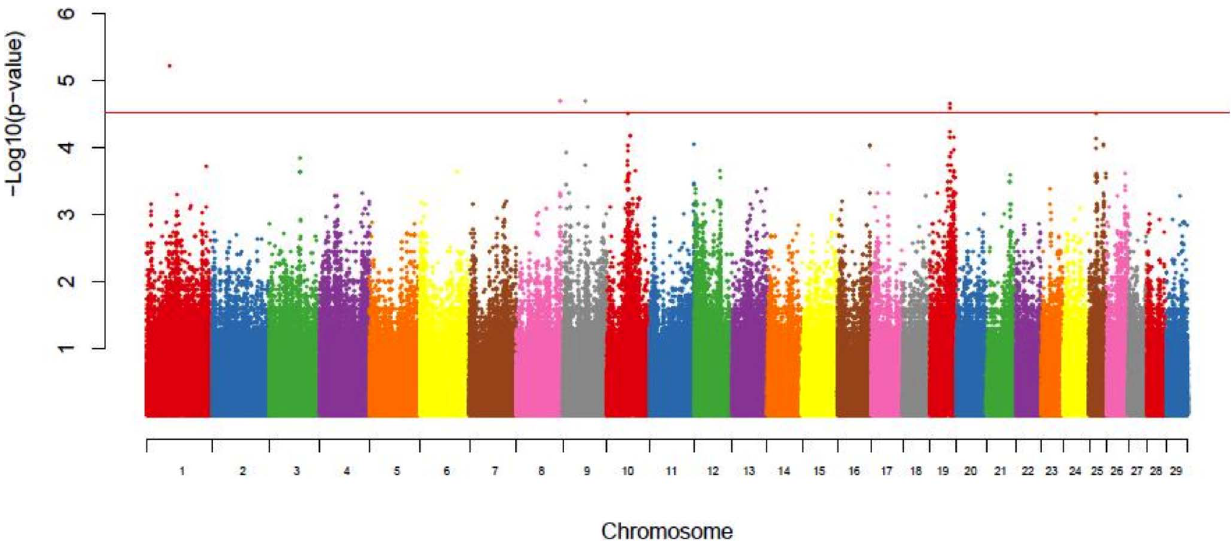
Figure 6. Genome-wide association or Manhattan plot of significance values for high fertile compared to low fertile heifers. The results of the genome-wide association analysis are shown for chromosomes 1 through 29 and the X chromosome (labeled as 30). The results are plotted by the 2 log 10 significance values on the y-axis and the chromosomal location for each SNP tested on the x-axis. The red line represents the Wellcome Trust threshold for moderate evidence for significance association.